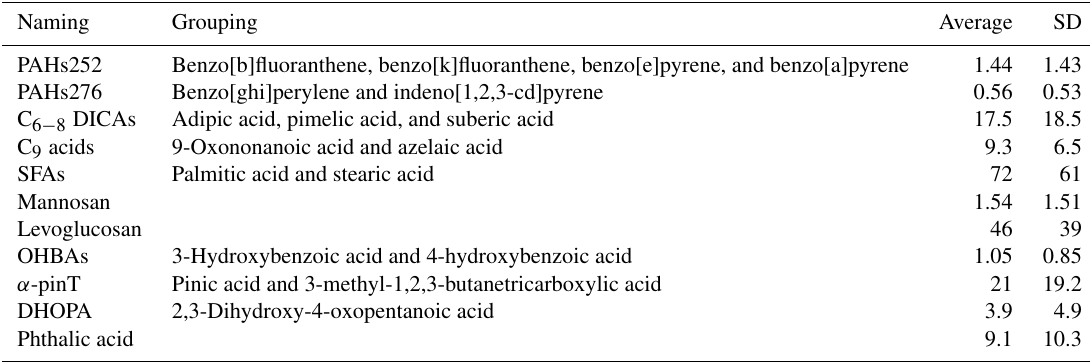
Table 2. Abundance and naming of measured organic markers (ngm − 3 ) used in the MM-PMF